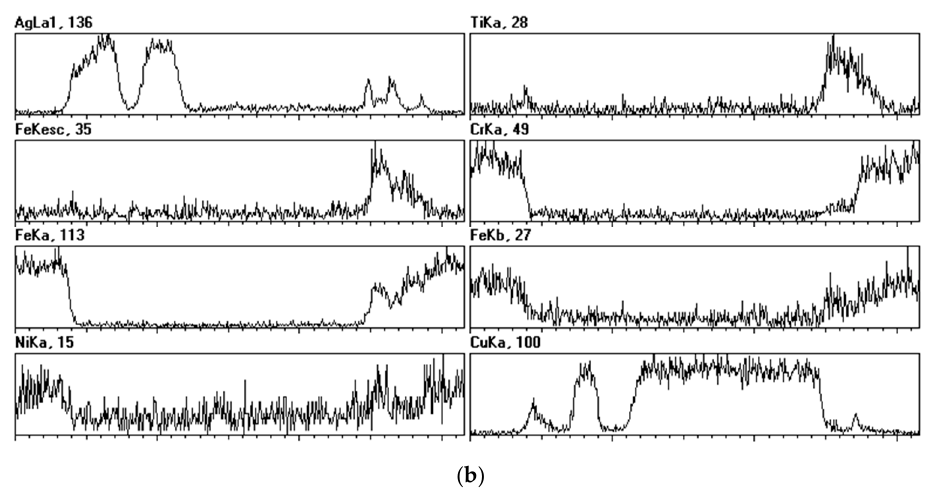
Figure 2. ( a ) SEM micrograph and ( b ) energy dispersive spectroscopy (EDS) line scan results from the cross section of a 316L stainless steel/Cu ‐ Ag ‐ Ti brazed joint.